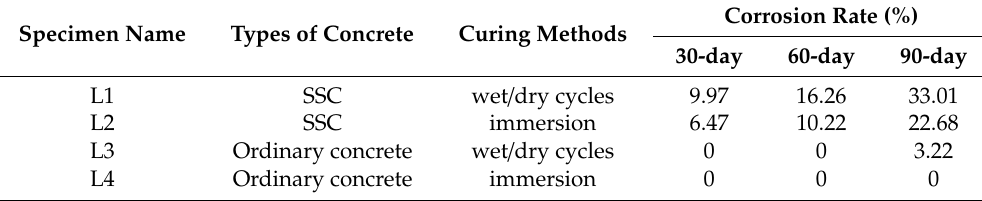
Figure 3. Statistics of corrosion rate and weight loss rate; ( a ) corrosion area statistics, ( b ) rebar quality statistics. Table 3. Corrosion rate of specimens.